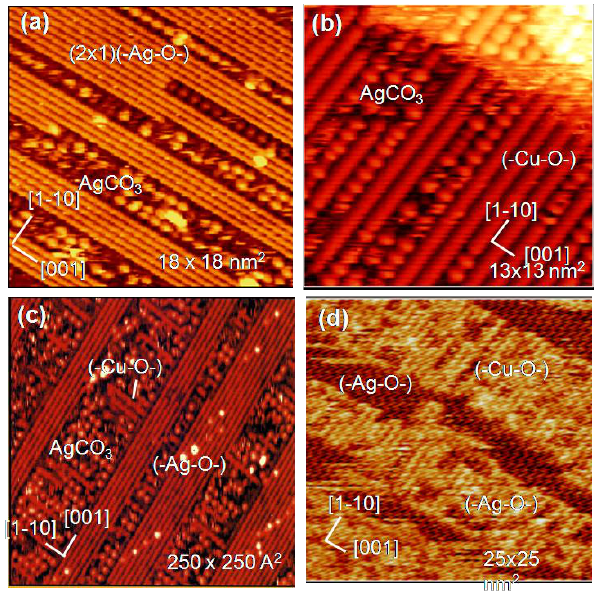
Figure 11. Selective reaction of (-Ag-O-) strings on the Ag(110) surface; ( a ) When a (3 × 1) (-Ag-O-) Ag(110) is exposed to CO , the (3 × 1)(-Ag-O-) phase is compressed to a 2 (2 × 1) phase by forming Ag-CO dots; ( b ) Cu atoms deposited on a composite Ag(110) 3 surface of (-Ag-O-) strings and Ag-CO dots undergo selective reaction with the (-Ag-O-) 3 strings to form (-Cu-O-); ( c ) By scanning a composite Ag(110) surface by a Cu/W-tip, the Cu atoms transferred from the W-tip react selectively with AgCO dots to form (-Cu-O-) 3 strings. The first sweep of the surface by a Cu/W-tip shows in (c) and after the ten times sweep in ca. 2 min is shown in ( d )